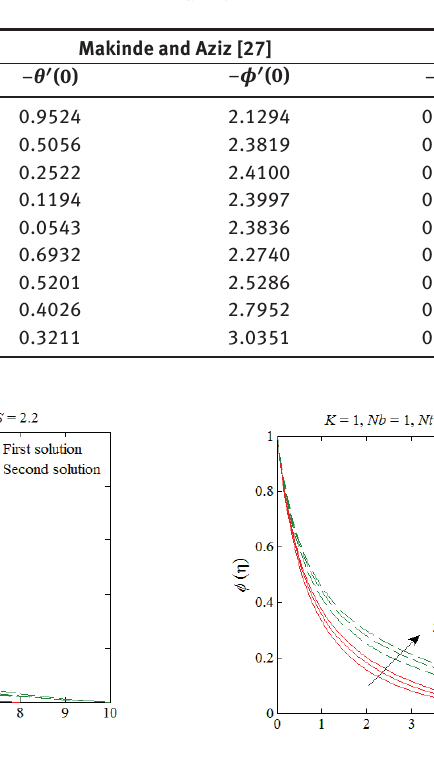
Table 1: Comparison of − θ (cid:2) (0) and − ϕ (cid:2) (0) when S = 0, Pr = Le = 10, R d = γ = ∞ in case of stretching sheet f (cid:2) (0) = 1 .